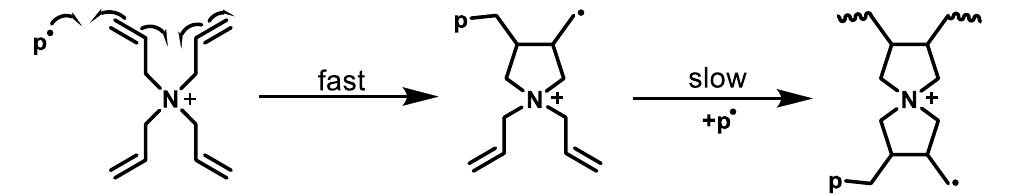
Figure 4. Ring closing reaction of the polymerisation of TAA + .